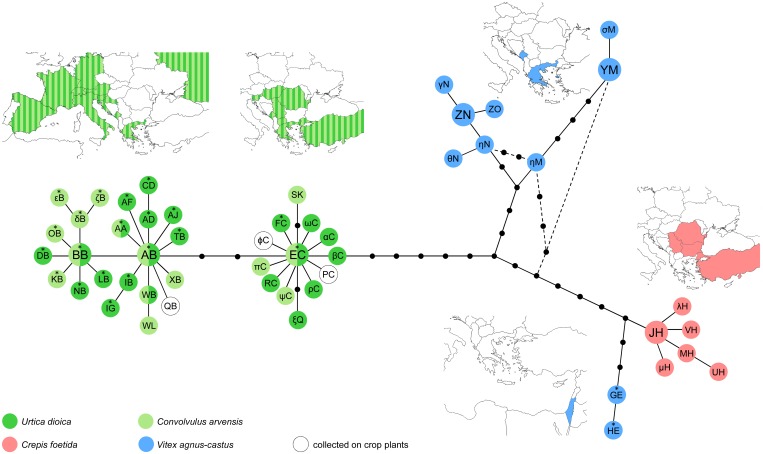
The phylogenetic haplotype network obtained using median-joining and statistical parsimony algorithms on concatenated COI-tRNA(Leu)-COII and 16S-tRNA(Leu)-ND1 mitochondrial gene regions of the 51 Hyalesthes obsoletus haplotypes identified in this and previous studies.Haplotype colors correspond to the host-plant associations. Haplotypes detected in previous studies [8, 11, 15, 37] are marked with an asterisk (*). The most common haplotypes within each haplogroup are noted with enlarged circles. Dashed lines represent alternative variants of network formations obtained using both algorithms. Black dot vertices represent missing or unsampled haplotypes. Distribution maps are given above each host-associated H. obsoletus haplogroup. Each detected haplogroup’s country is designated on maps in the color corresponding to the associated host-plant. Because Convolvulus arvensis and Urtica dioica share a number of H. obsoletus haplotypes, BB-AB and EC haplogroup distribution is designated in two shades. Haplotypes detected in the two previously reported H. obsoletus populations collected on crop plants in Romania and Russia (Radovanu and Mayak) [7] are not colored.